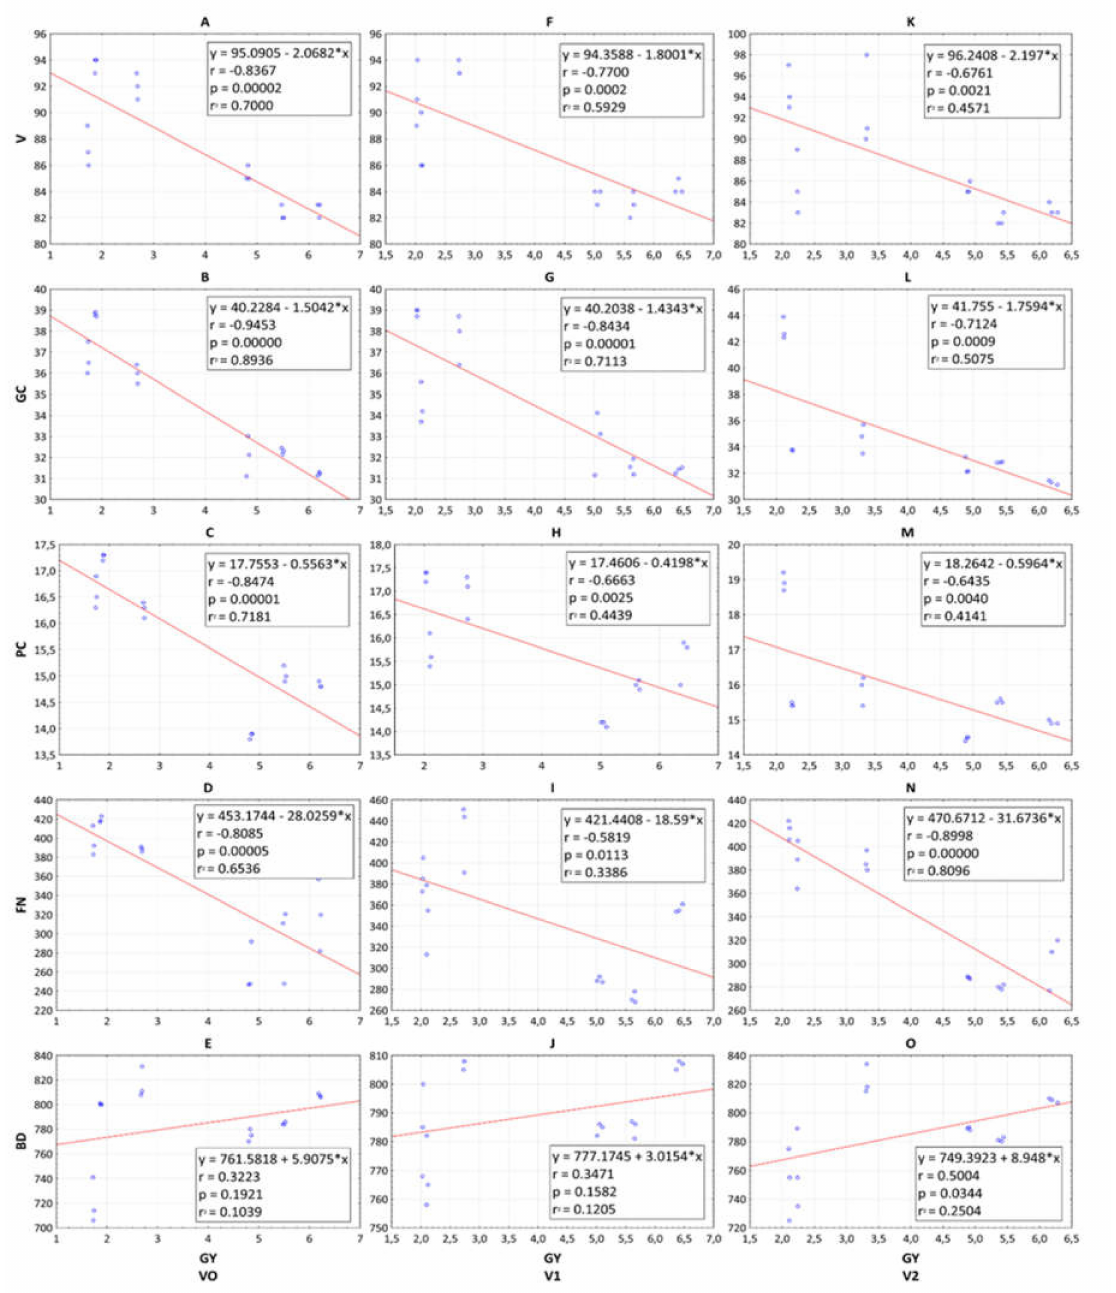
Figure 3. Relationships between grain yield (GY) on all experimental treatment (V0–V2) and vitreousness (V) ( A , F , K ), gluten content (GC) ( B , G , L ), protein content (PC) ( C , H , M ), falling number (FN) ( D , I , N ) and bulk density (BD) ( E , J , O ). The linear relationship between parameters is represent by solid lines. Linear equations, correlation coefficient, probability and regression are inserted inside